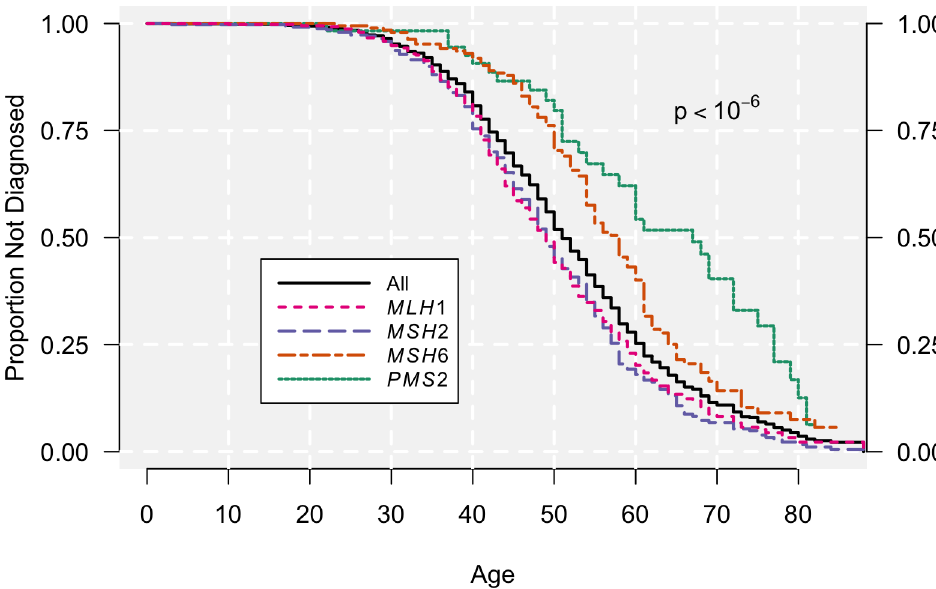
Fig 1. Kaplan-Meier estimates of time to first Lynch-associated cancer diagnosis in the Swedish Registry data, both overall and stratified by mutational status. The x axis displaysage (years) and the y axis displaysthe probabilityof being free from